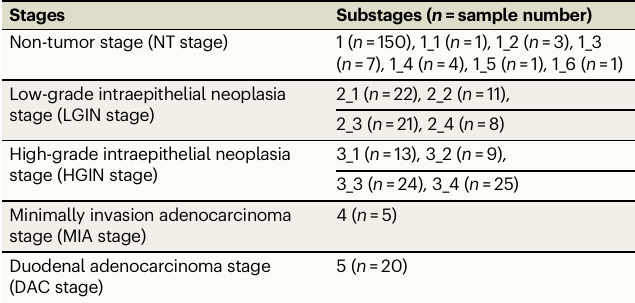
Table 2 | Subclassi fi cation information and the number of substage samples in the D subtype Stages